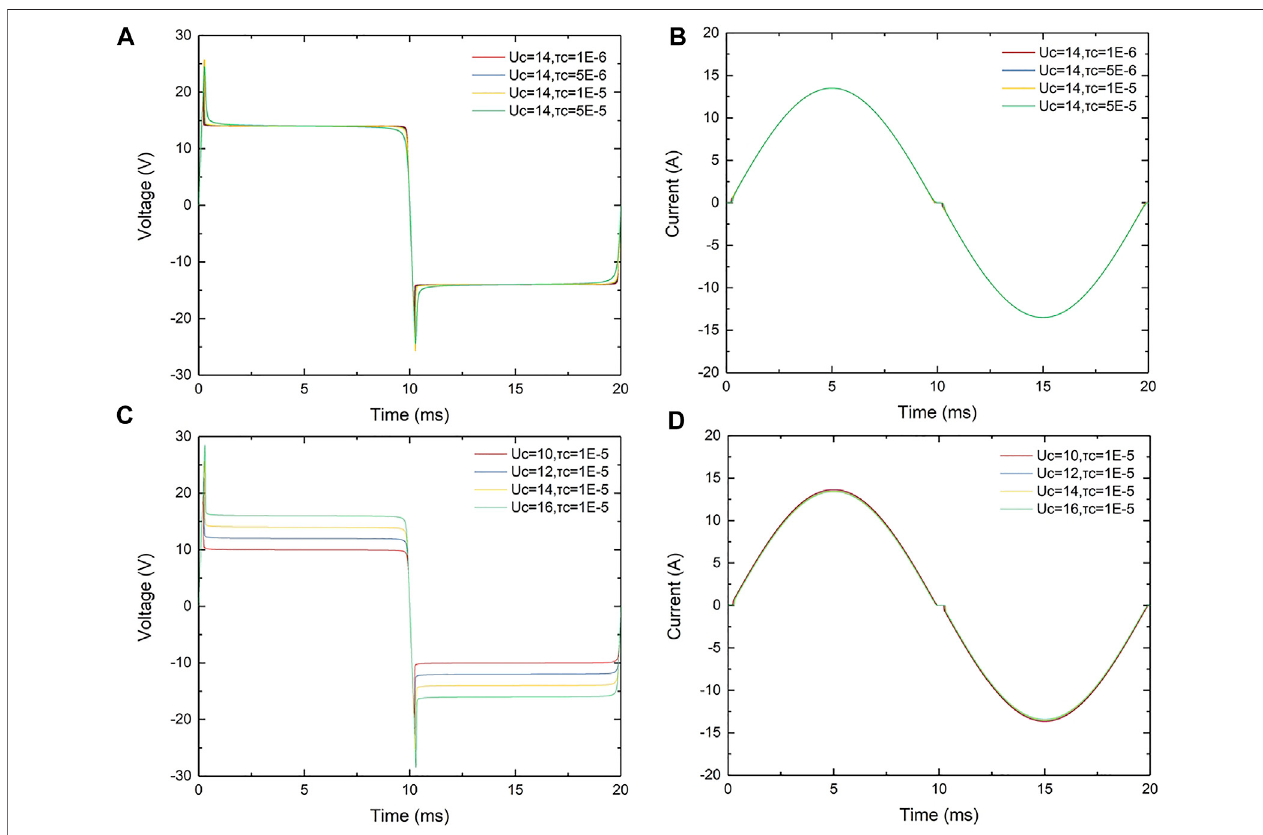
FIGURE3| EffectofCassieparameters. (A) Arcvoltageofdifferent τ c , (B) arccurrentofdifferent τ c , (C) arcvoltageofdifferent U c ,and (D) arccurrentofdifferent U c .